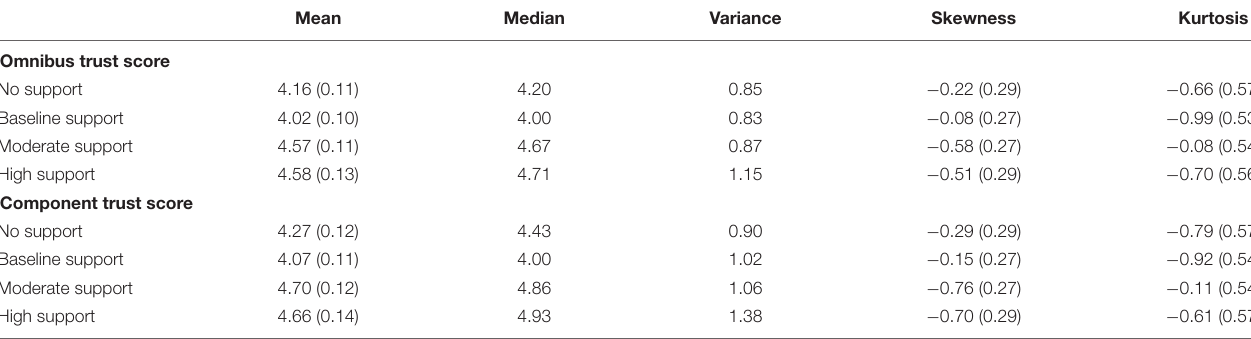
TABLE 6 | Trust and component trust scores descriptives statistics (standard error in